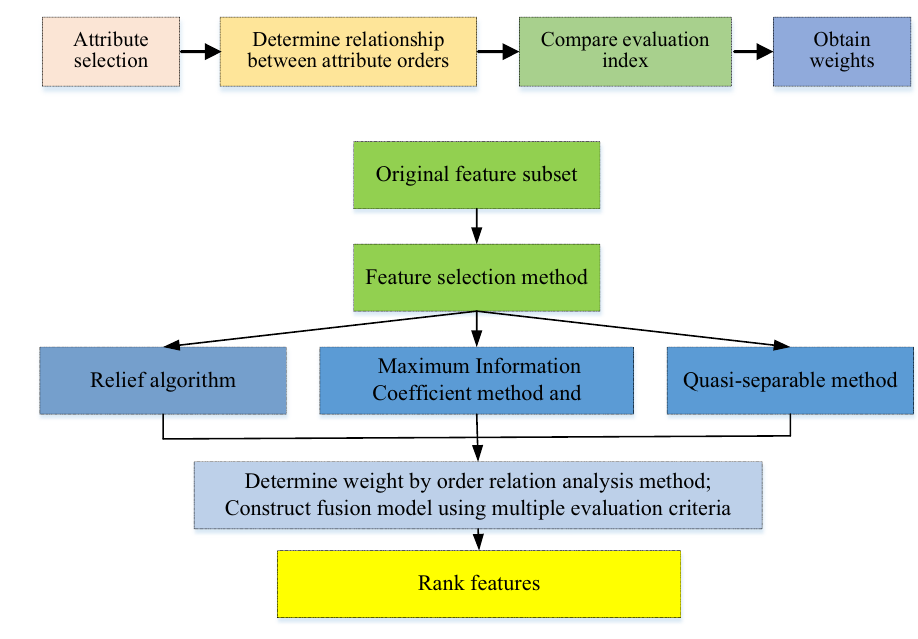
Fig. 1 Steps for order relation analysis method Attribute